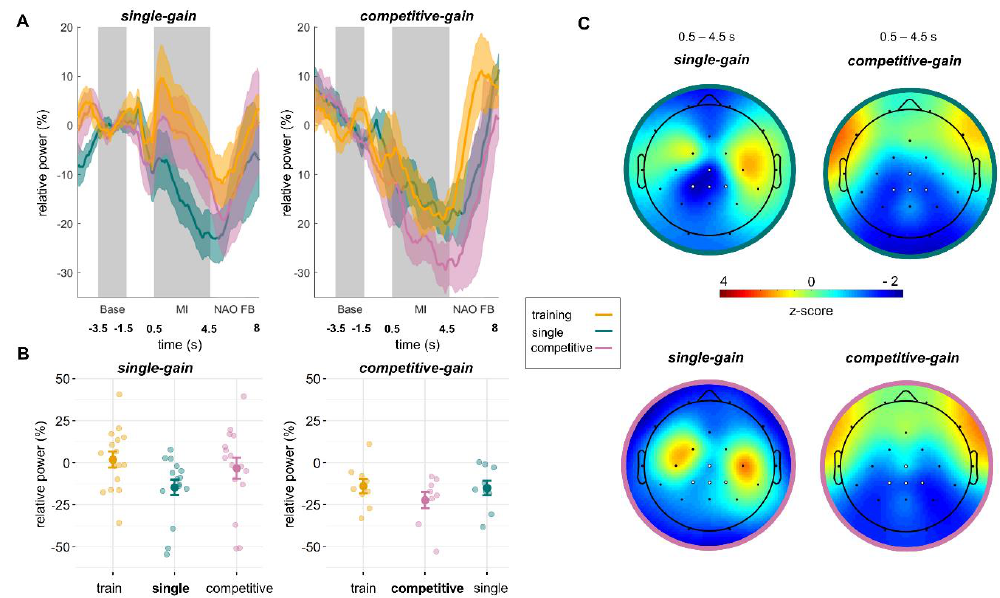
Figure 3. Differences in MI-induced relative ERD between the groups single-gain and competitive-gain. ( A ) Group mean and standard error of relative ERD time courses for all MI conditions for the single-gain (left) and competitive-gain (right) groups. Grey areas indicate the baseline and MI interval. ( B ) Group mean, standard error, and single-subject means of relative ERD during the MI interval for all MI conditions for the single-gain (left) and competitive-gain (right) groups. The NF condition with ERD gain in comparison to the other NF condition is displayed in the middle. ( C ) Group mean topographies of relative ERD during the MI interval for both MI NF conditions (top azure frame: single; bottom pink frame: competitive multi-user) for each group ( single-gain on the left, competitive-gain on the right). The ROI for o ffl ine analysis is highlighted in white (CZ, CP1, CPz, and CP2). Topographies were z-transformed within each condition for illustration purposes.